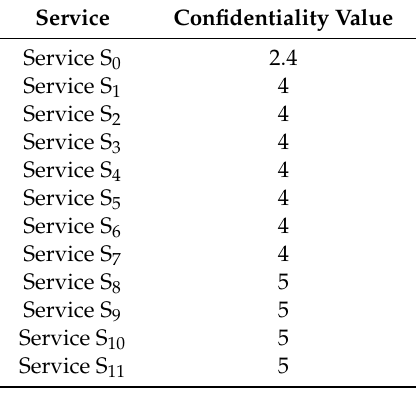
Table8. Confidentialityvaluesofeachserviceinvocationelementinclient-sideinformationreceptionmodule.